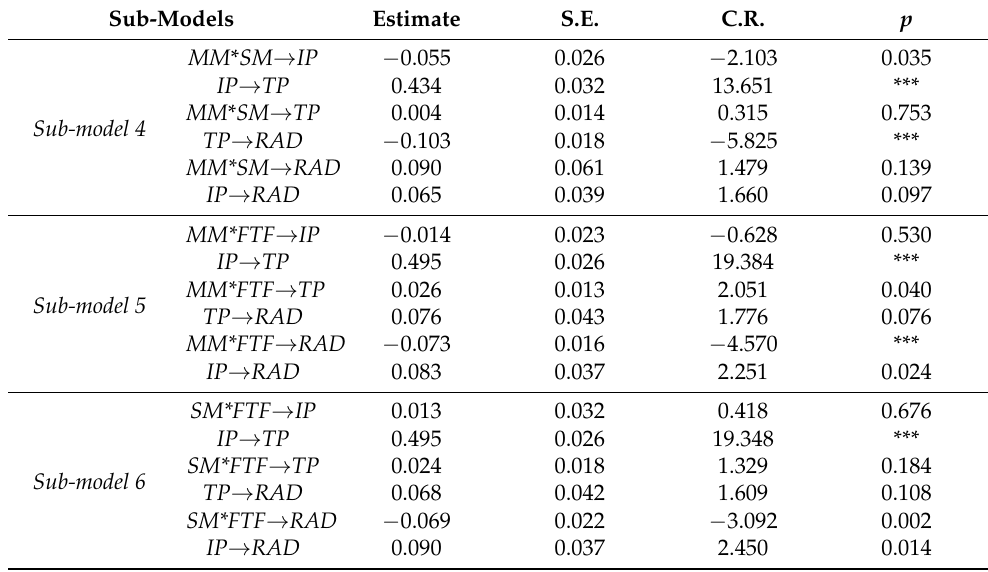
Table 7. Mediation effect analysis of sub-models